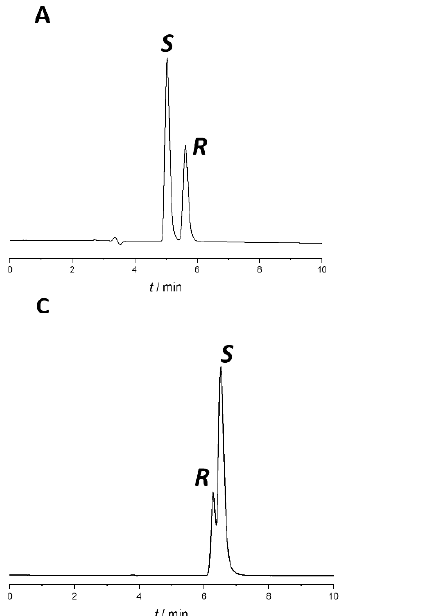
Figure 2. Representative chromatograms from the method screening phase. ( A ): Lux Amylose-1 with MeOH:acetic acid 100:0.1 ( v / v ) ( B ): Lux Amylose-1 with ACN: acetic acid 100:0.1 ( v / v ), ( C ): Lux Cellulose-1 with MeOH:acetic acid 100:0.1 ( v / v ), ( D ): Lux Cellulose-4 with IPA:acetic acid 100:0.1 ( v / v ). All columns had identical dimensions: 150 mm × 4.6 mm, 5 µm. Other chromatographic pa- rameters: flow rate: 0.5 mL/min, column temperature: 25 °C, detection at 230 nm.